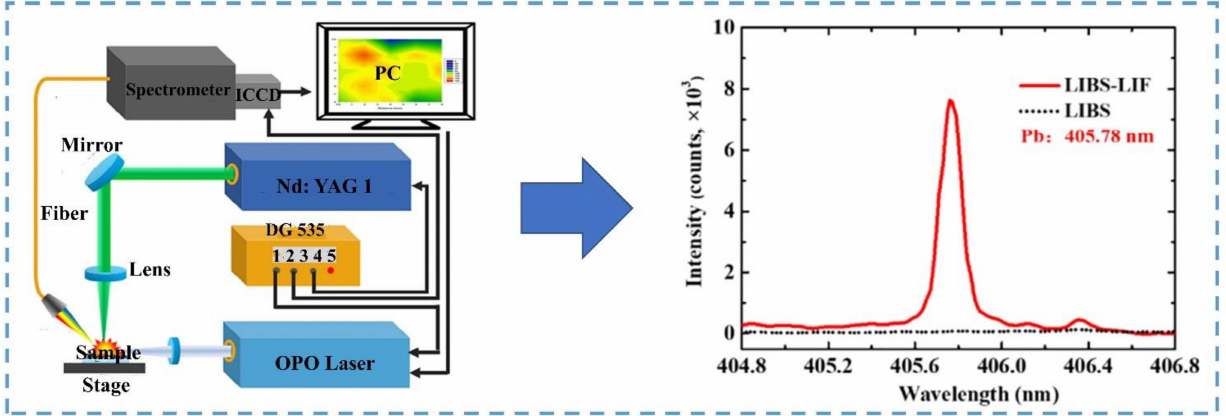
Figure 5. A device for combining LIBS with laser-induced